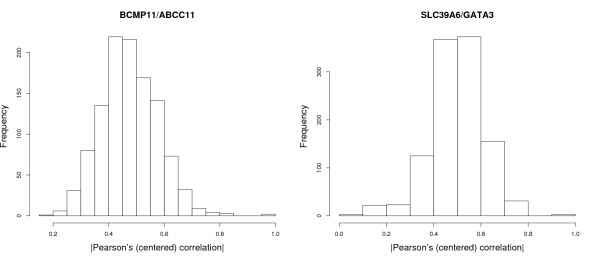
Histograms of correlations between significantly differentially expressed genes and the genes that induced them. (Left) Histogram of the maximum absolute Pearson's (centered) correlation of the genes that are significantly differentially expressed between the BCMP11/ABCC11 groups with BCMP11 and with ABCC11. (Right) Histogram of the maximum absolute Pearson's (centered) correlation of the genes that are significantly differentially expressed between the GATA3/SLC39A6 groups with GATA3 and with SLC39A6.